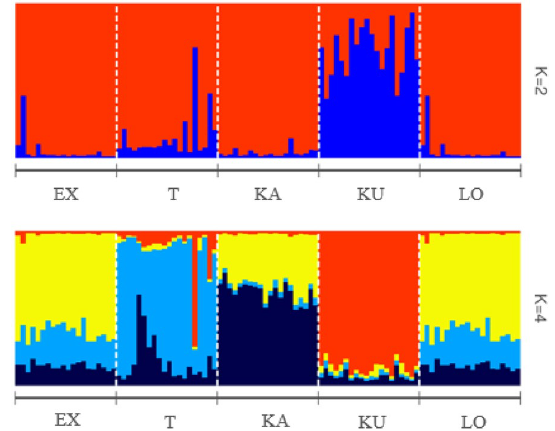
Fig. 10 Estimated genetic population structure of Plantago maxima populations based on ISSR markers for K CTU RE with the location priory model. EX, Soroksár Botanical Garden – ex situ; TAT, Tatárszentgyörgy; KAK,Kakucs; KUN, Kunpeszér; LO, Táborfalva military shooting